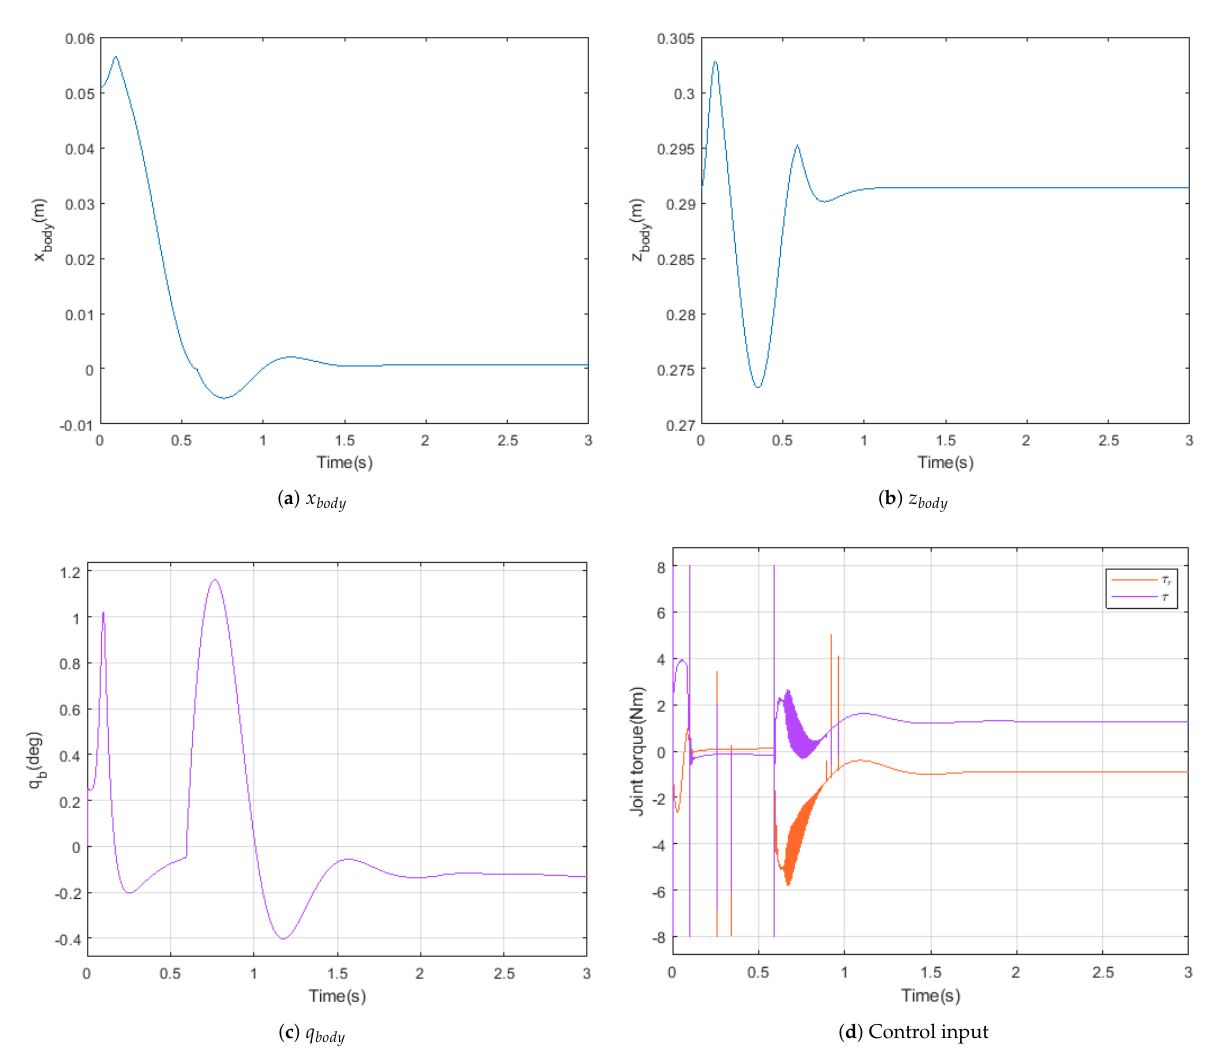
Figure 15. States and input of swing